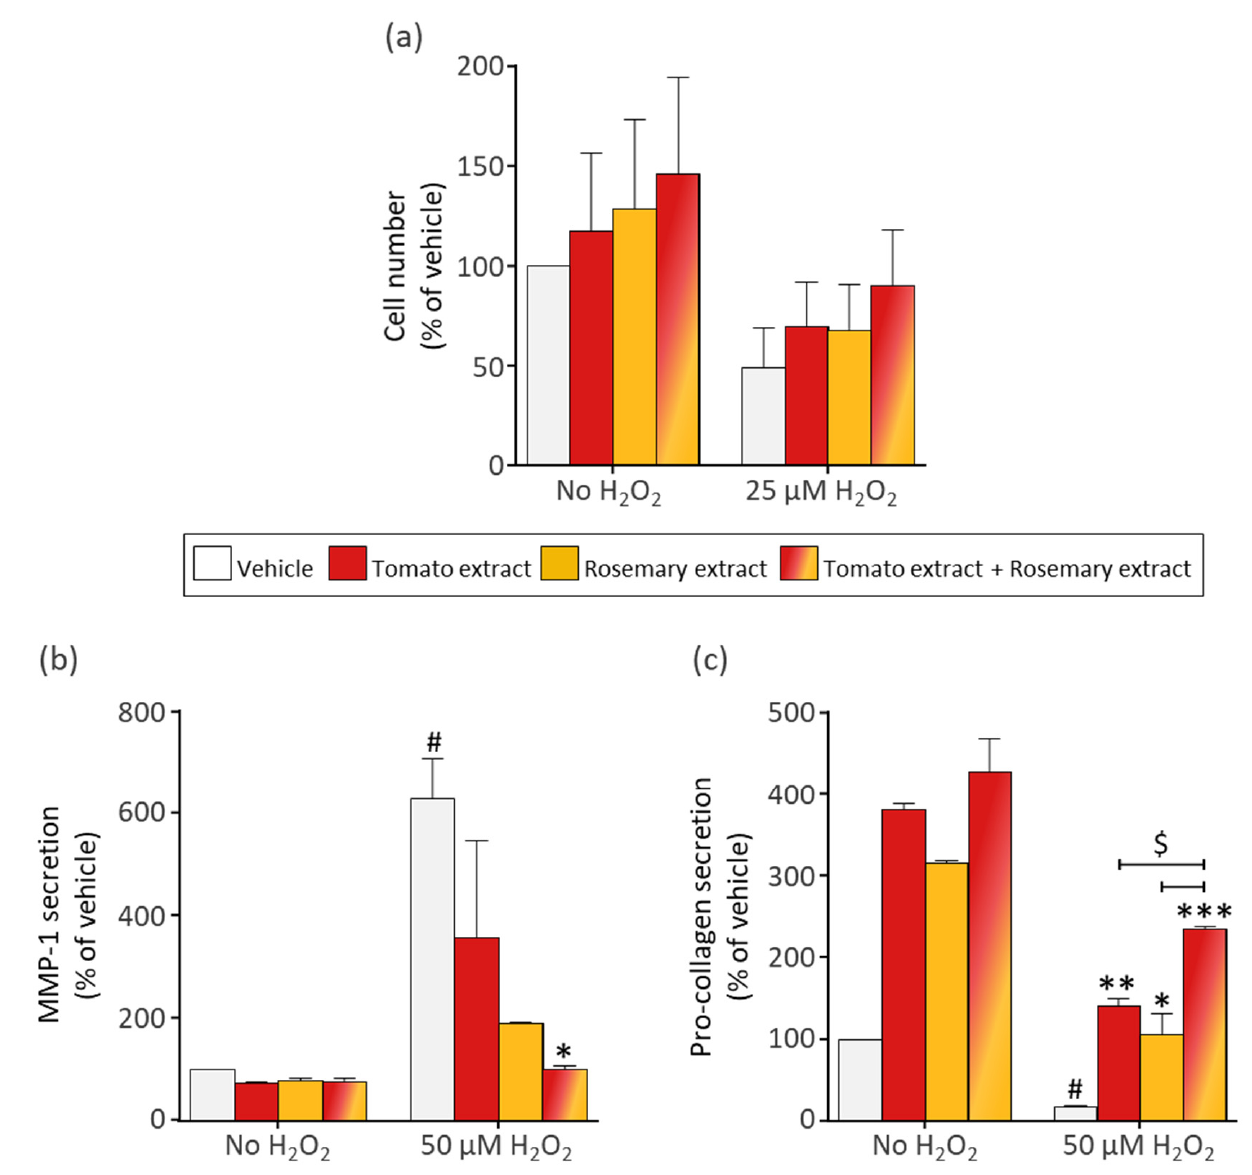
Figure 3. Protection from H 2 O 2 -induced cell damage was improved by a combination of tomato and rosemary extracts. NHDF cells were pre-incubated for 24 h with tomato extract (2.5 µ M lycopene), rosemary extract (2.5 µ M carnosic acid), or their combination. Then, H 2 O 2 was added at the indicated concentrations for an additional 24 h. The cell number ( a ), and secretion of MMP-1 ( b ) and pro-collagen 1a1 ( c ), were determined as described in the legend of Figure 1. Results are presented as a percent of the values without H 2 O 2 . Y-axis scales: 100% of cell number was 8067 ± 6141 cells/well; 100% of the MMP-1 secretion was 84 ± 5 pmol per 1000 cells; 100% of the pro-collagen secretion was 16.5 ± 0.5, much lower than other experiments’ pmol per 1000 cells. Values are the means ± SD of 2–3 experiments, each performed in triplicate. #, p < 0.05, significant difference between the vehicle with and without H 2 O 2 . * p < 0.005, ** p < 0.01, *** p < 0.001), significant difference between the vehicle and other treatments in the presence of H 2 O 2 . §, p < 0.05, between the combination and individual